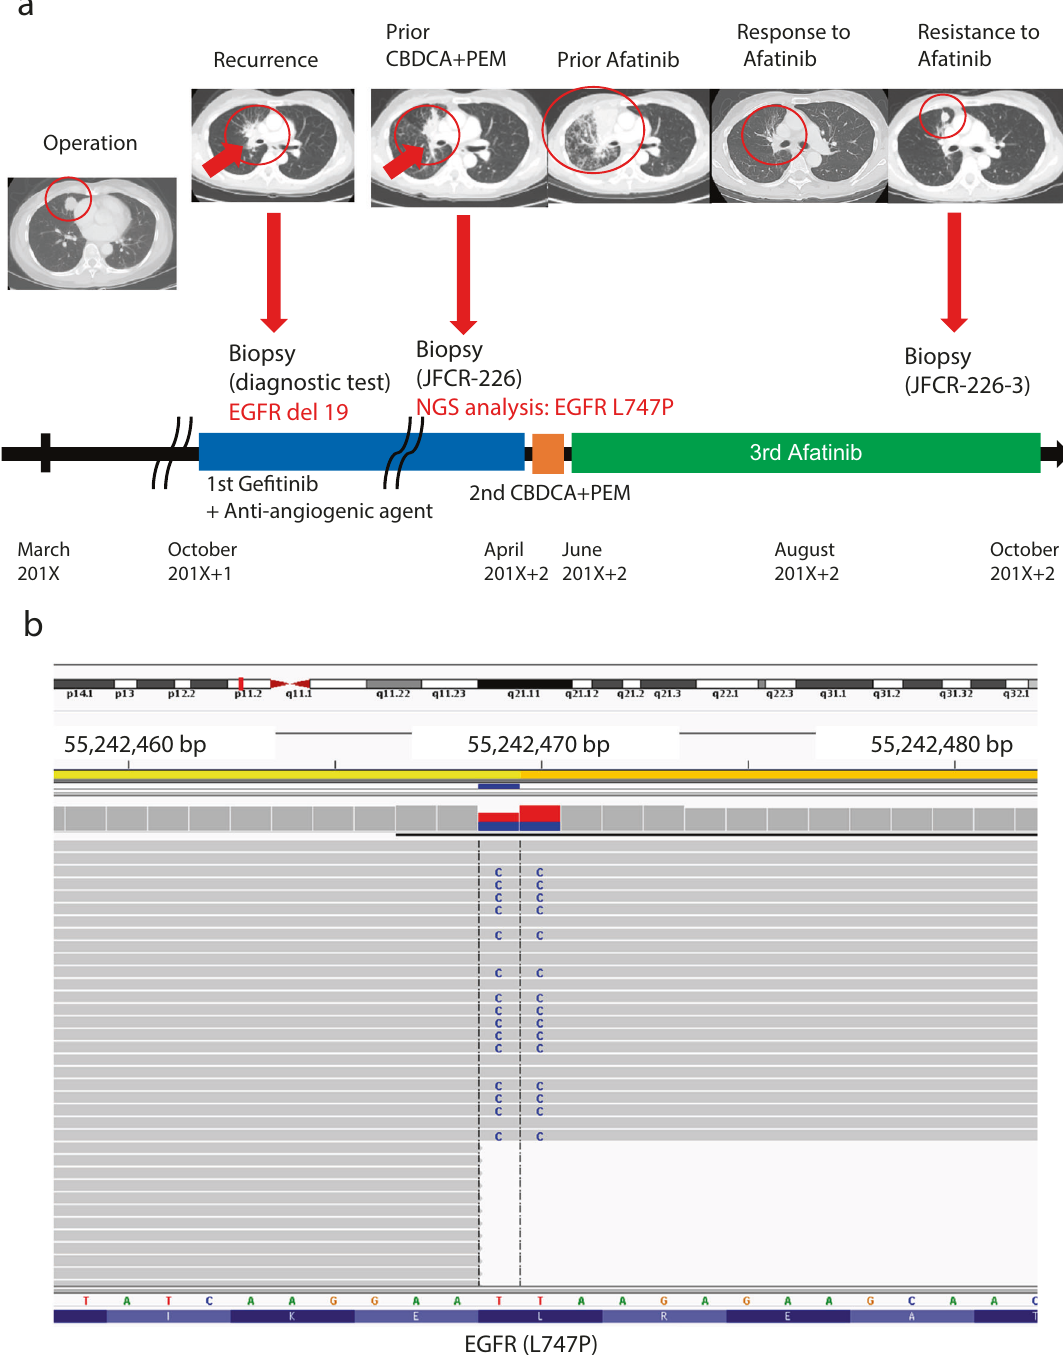
Fig. 1 Clinical course of the case and sequence data of EGFR. a Time series from the left: computed tomography images of patients at baseline, relapse, and subsequent treatment. Resistance mutations identi fi ed in the regeneration test are shown in the fi gure. Treatment details are shown below. b Detailed sequence data of JFCR-226 around the EGFR-L747 residue shown in integrated genome browser (IGV)- style